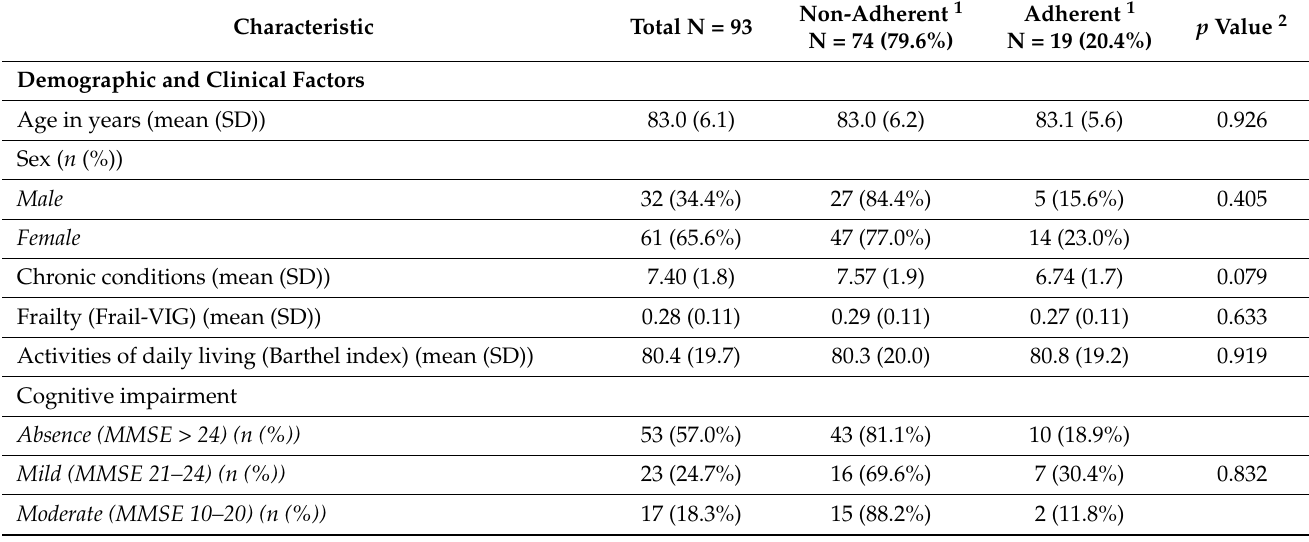
Figure 1. Flow diagram: study participation and selection process. Abbreviations: ICC: intermediate care center. Table 1. Characteristics of non-institutionalized older patients with multimorbidity and polypharmacy admitted to an intermediate care center by medication adherence